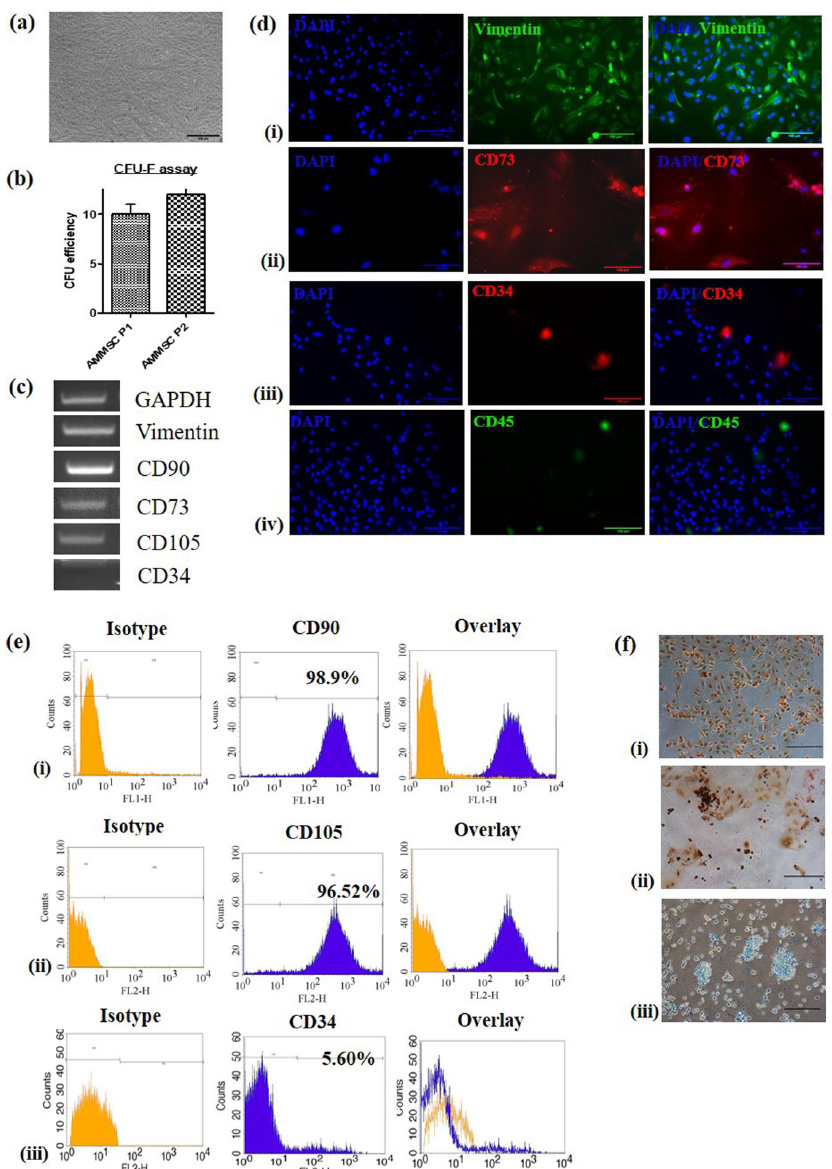
Figure 1. Isolation of amniotic-membrane mesenchymal stem cells (AM-MSC) and its characterization ( a ) Photomicrographs of AM-MSC at passage 2 (4 × magnification, scale bar = 200 µ m). ( b ) Colony formation ability of AM-MSC at passage 1 and 2. ( c ) Analysis of MSC markers vimentin, CD90, CD73 and CD105 and negative marker CD34 by RT-PCR. ( d ) Immunofluorescence staining revealing the presence of cytoskeletal marker ( i ) vimentin and specific surface markers ( ii ) CD73, ( iii ) CD34 and ( iv ) CD45 (20 × magnification, scale bar = 100 µ m). ( e ) Analysis of MSC surface markers by flow cytometry showing ( i ) 98.9% cells positive for CD90, ( ii ) 96.52% cells positive for CD 105, ( iii ) 94.28% cells negative for CD 34. ( f ) Photomicrographs showing trilineage differentiation in AM-MSC, ( i ) adipocytes stained with oil red ‘O’ showing oil droplets stained red, ( ii ) 2% Alizarin red staining performed on osteocytes showing the calcium deposits-stained reddish brown, ( iii ) Alcan blue staining performed on chondrocytes showing polysaccharides stained blue (20 × magnification, scale bar = 100 µ